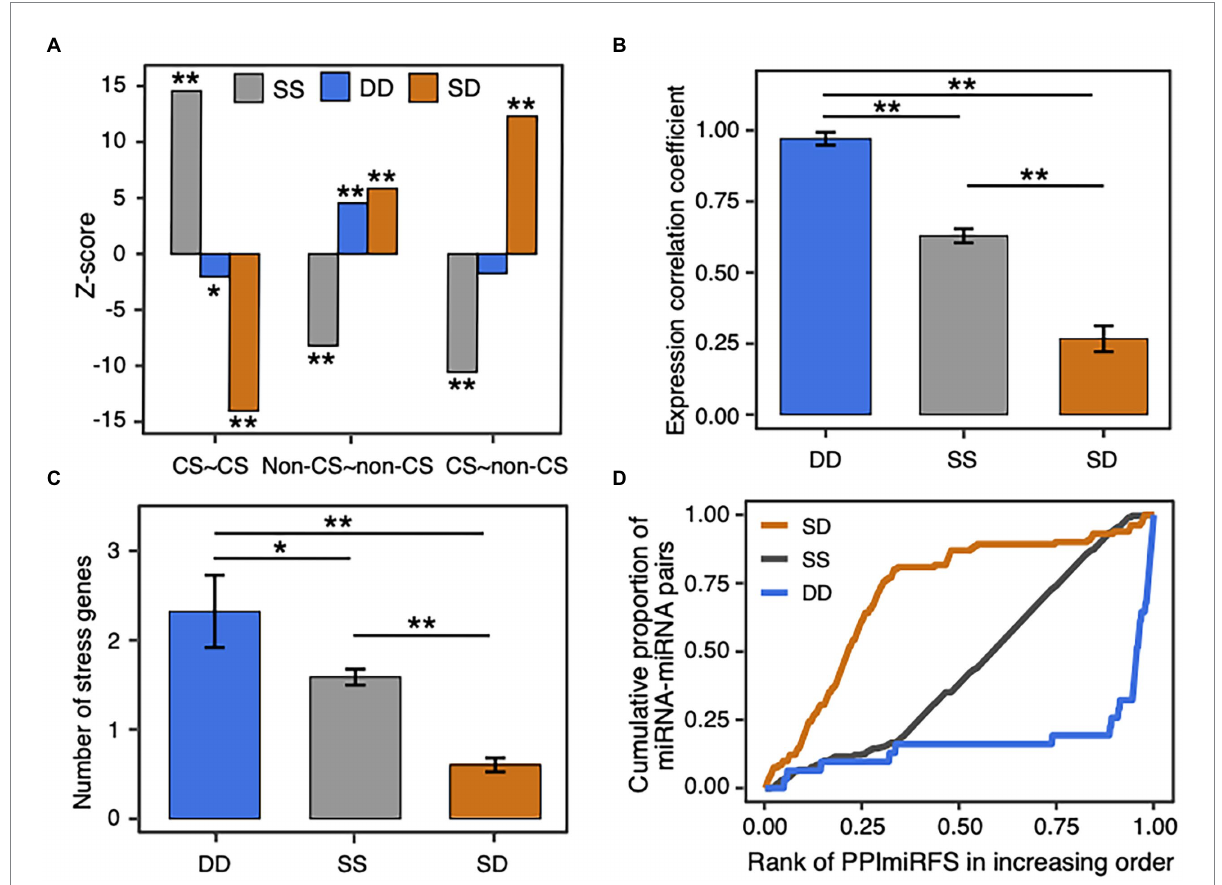
FIGURE 6 Biological significance of SS, DD, and SD miRNA–miRNA crosstalk. (A) Z-score distribution of the SS, DD, and SD miRNA pairs in different conservation groups. miRNAs are classified into conserved (CS) and non-conserved (non-CS) groups. The observed number of miRNA pairs with the same crosstalk type between conservation groups in the real network was compared with the expected number in the 1,000 randomized networks, which were generated by randomly assigning each crosstalk type to an edge in the original network (see Materials and methods). The enrichment was calculated using Z-score and the corrected p -value for multiple hypothesis testing. The symbol * denotes p -value < 0.01 and ** denotes p -value < 0.001. (B) Expression correlation of miRNA pairs with different crosstalk types. Data are represented as the average Pearson’s correlation coefficient ± standard error. The symbol * denotes p -value < 0.01, and ** denotes p -value < 0.001 using Analysis of Variance (ANOVA) with the Tukey HSD post-hoc method and the Benjamini and Hochberg correction. (C) Number of stress genes co-regulated by the SS, DD, and SD miRNA pairs. (D) Distribution of the cooperative miRNA pairs in different ranks of PPImiRFS scores. PPImiRFS scores were sorted